Question: In a single sentence, describe what this figure presents.
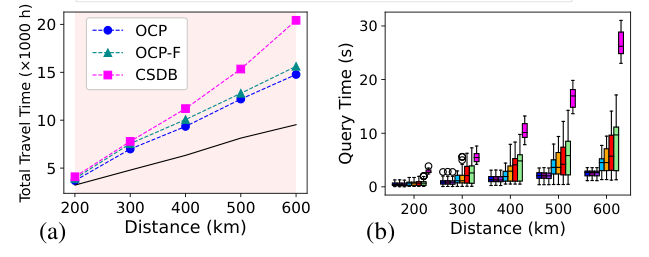
Answer: Performance for varying the travel distance in SDS when the number of EVs is 1000: a) Total travel time in SDS b) Mean query time in SDS.